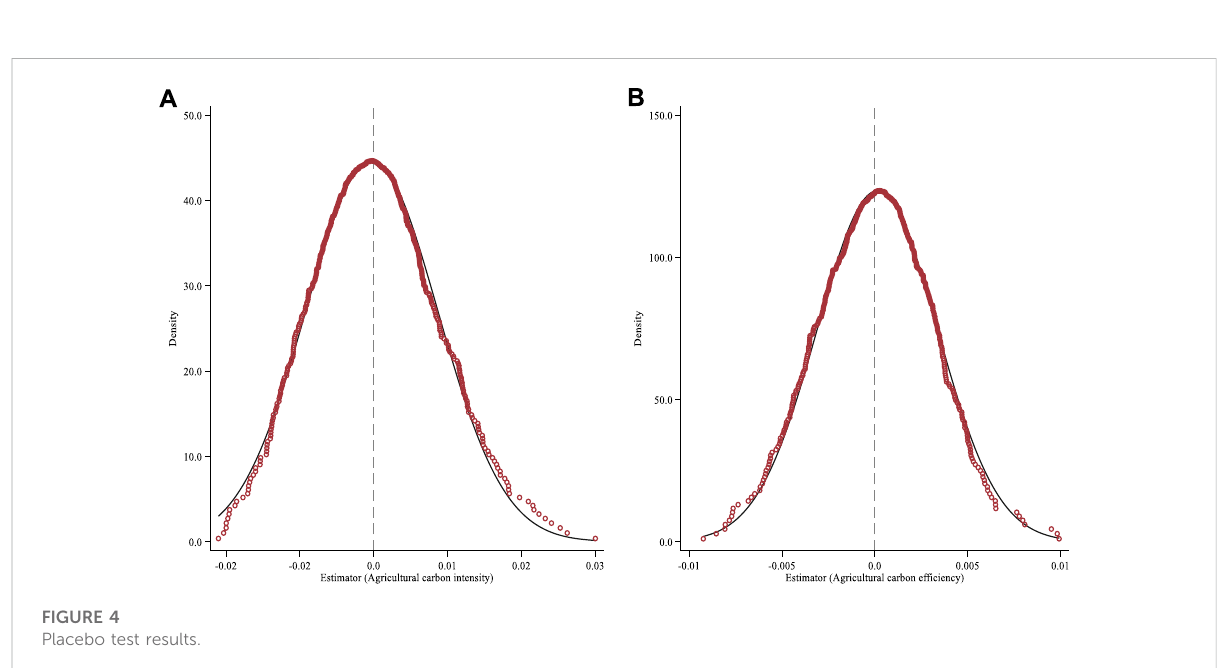
FIGURE 4 Placebo test